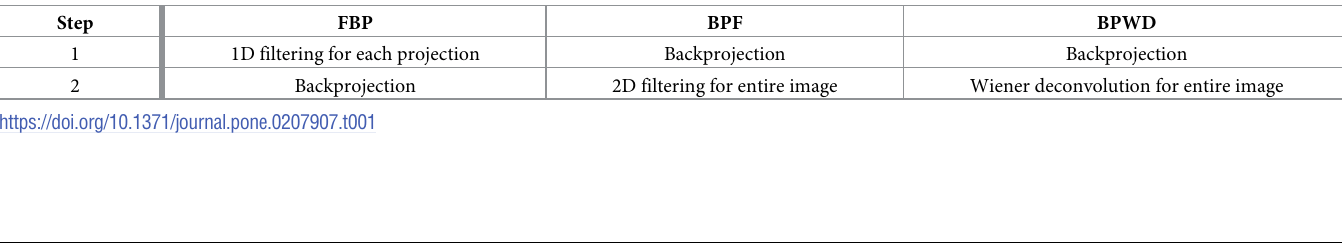
Table 1. Difference of three backprojection based